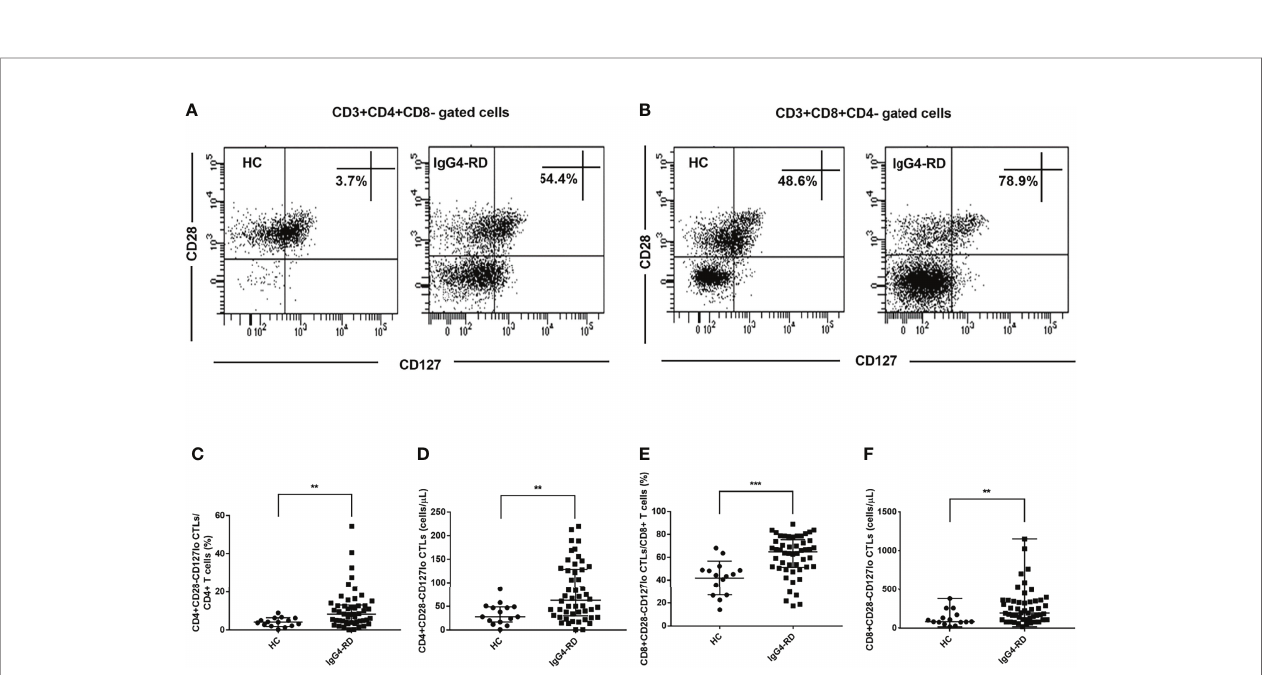
FIGURE 2 | Analysis of the levels of CD28-CD127lo CTLs in CD4 and CD8 T cells. CD4+CD28-CD127lo and CD8+CD28-CD127lo CTLs in the circulation of IgG4- RD patients (n = 50) and healthy controls (HCs, n = 15) were analyzed using fl ow cytometry. (A, B) Representative dot plots of fl ow cytometry analysis. CD4+CD28- CD127lo and CD8+CD28-CD127lo CTL percentages were indicated. CD127 was gated according to fl uorescence minus one (FMO) control of CD127. (C – F) The levels of circulating CD4+CD28-CD127lo CTLs and CD8+CD28-CD127lo CTLs were compared between IgG4-RD patients and HCs. The error bars represented the median with an interquartile range. The two-tailed Mann-Whitney test was used to compare two groups. ∗∗ P < 0.01; ∗∗∗ P <